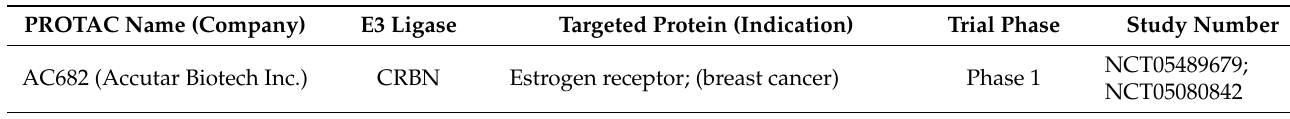
Table 1. PROTACs currently in clinical trials. Data from clinicaltrials.gov (https://clinicaltrials.gov/ ct2/home; accessed on 20 February 2023). NA—not